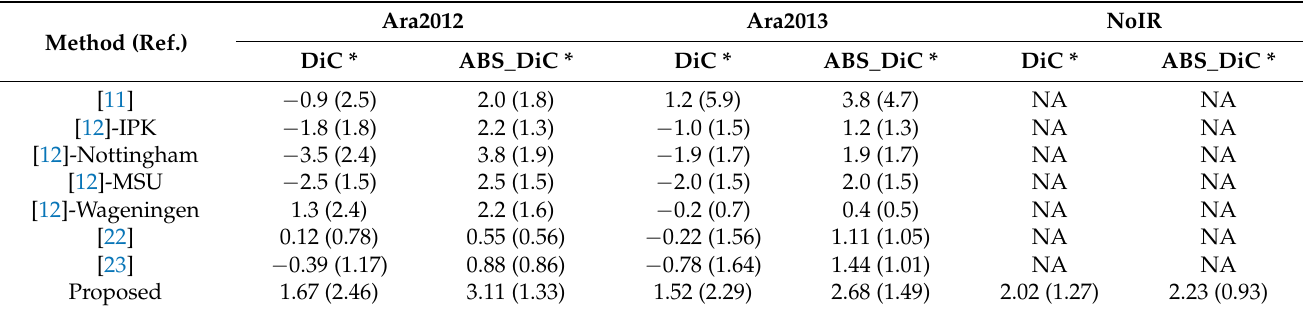
Table 6. Comparison of the values of DiC and